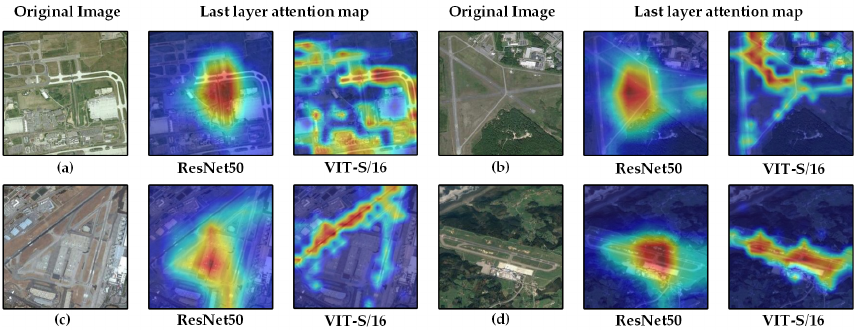
Figure 3. Original images in NWPU-R45 [24] and their attention maps in CNN and ViT. ( a ) ∼ ( d ) refer to four different airport scenes in the